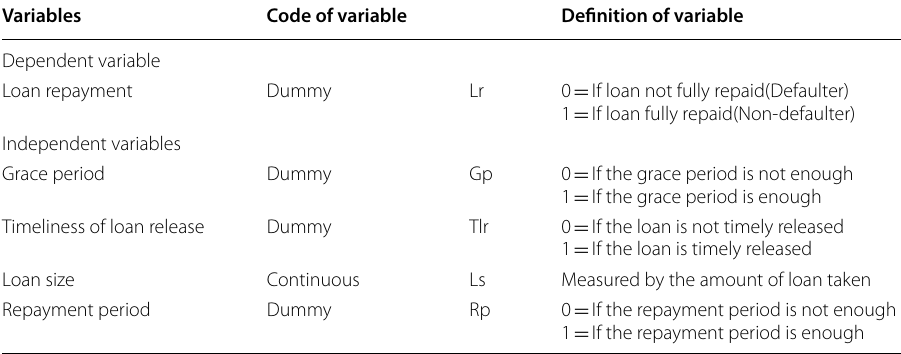
Table 1 Description of variables Variables Code of variable Definition of